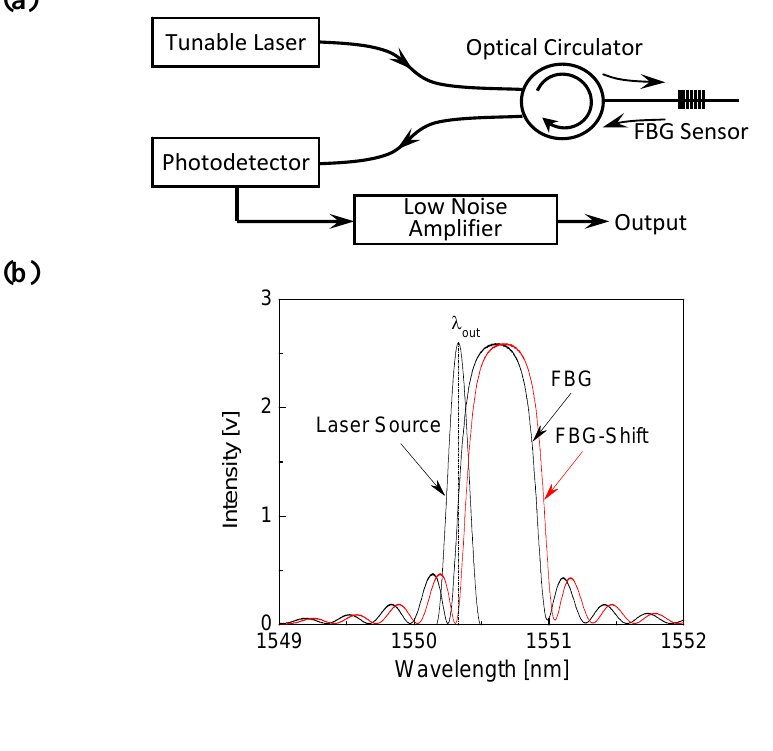
Figure 2. Sketch of the high-speed optical wavelength interrogation system in Figure 1. (a) FBG-based ultrasonic detection system. (b) A schematic illustrating the variation in reflectivity at the lasing wavelength when the FBG sensor